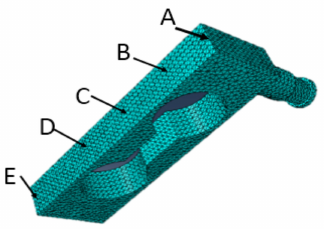
Figure 3. The distribution graph of observation points on